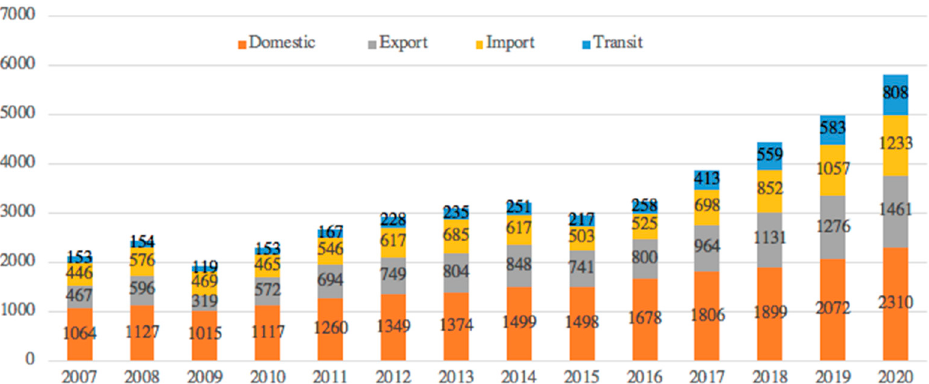
Figure 4. Overall container transportation on the network of Joint Stock Company (JSC) Russian Railways (in ‘000 TEUs). The data are based on the following sources [33–39].